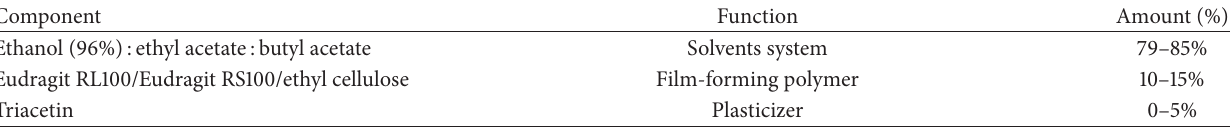
Table 3: Quantitative ranges of components in nail lacquer